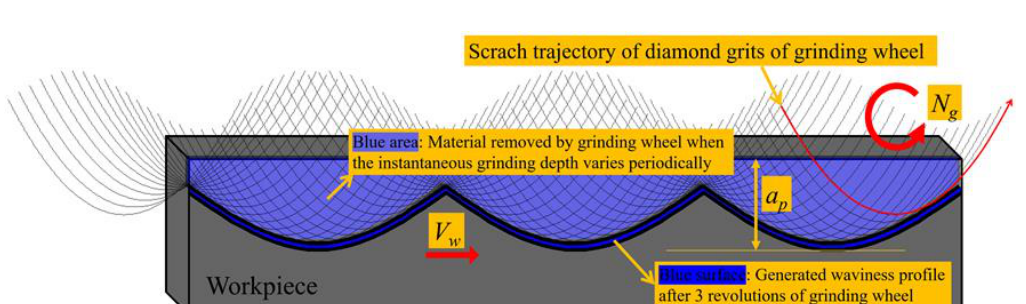
Figure 2. The grinding device scheme for the Fresnel micro-structured mold.